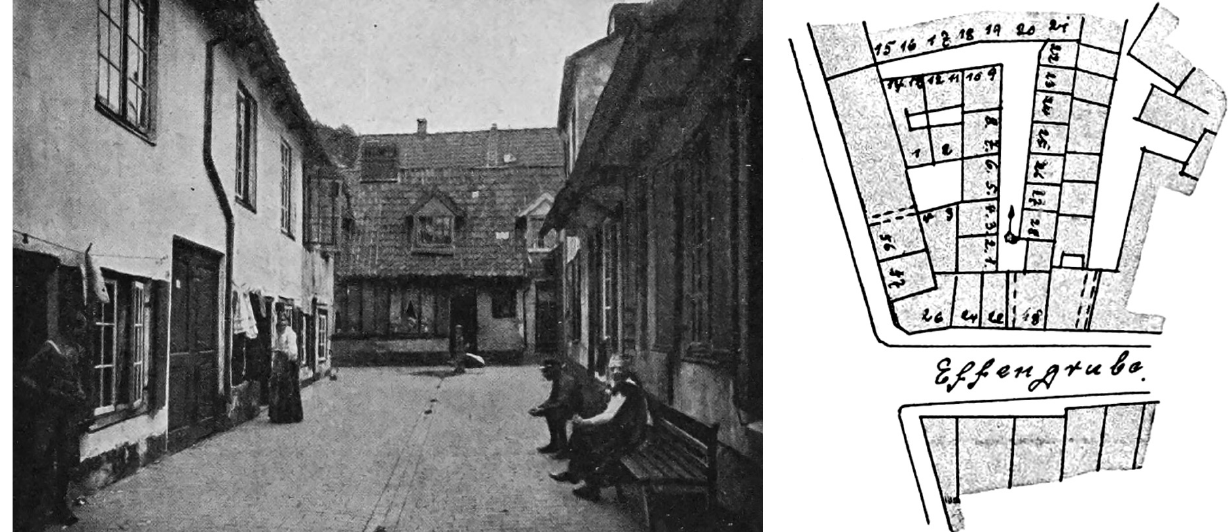
Figure 2. Photograph and plan of Blohmsgang dwelling corridor in Lübeck. Source: Harms (1907, plate 86). Urban Planning, 2022, Volume 7, Issue 1, Pages